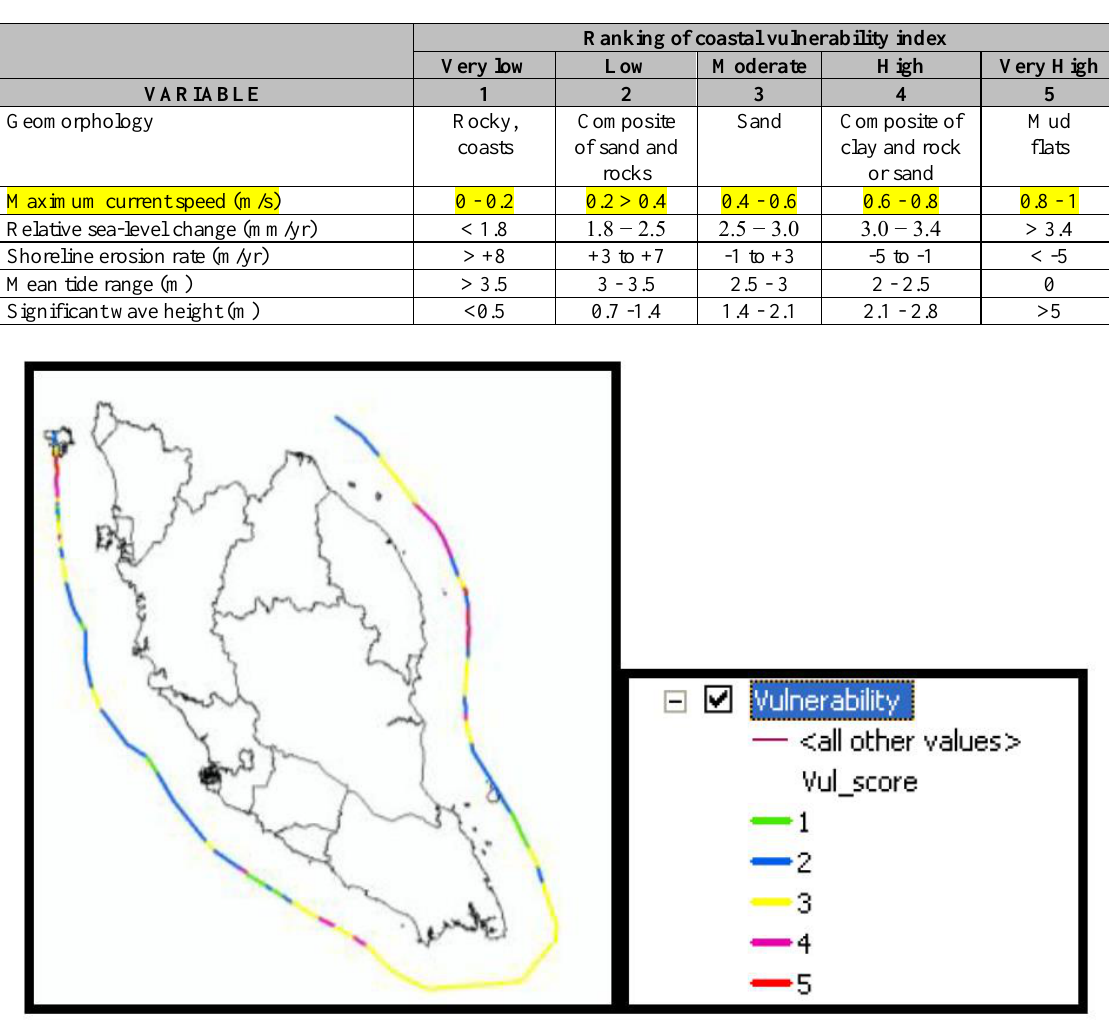
Figure 7. Peninsular Malaysia CVI based on study by Mohamad et al.